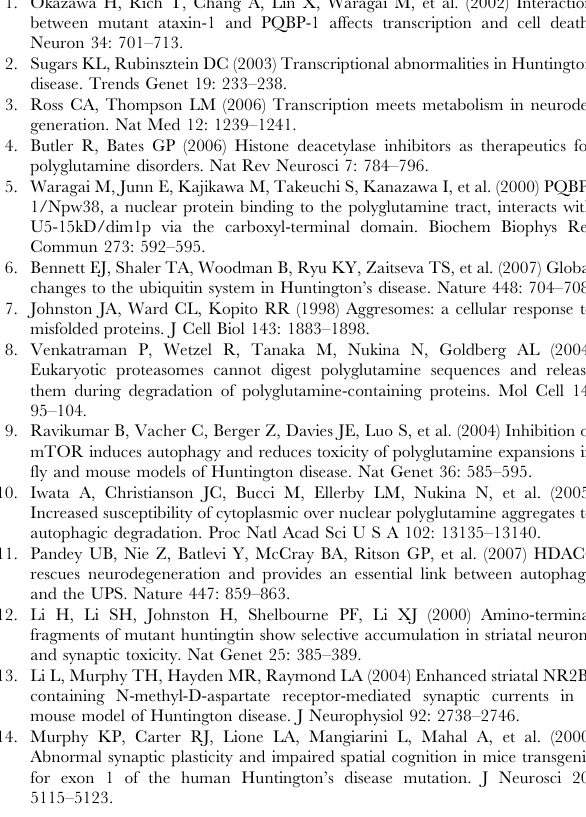
Figure S1 Different lifespans between Canton S and w 1118 genetic background flies. The lifespan was different among Canton S homozygous, w 1118 homozygous, and compound heterozygous background flies. Figure S2 The lifespan of the Canton S background flies was not affected by OK6 or Ku70 transgene. (A) Lifespan was not different between genetic controls and Ku70 overexpres- sion fly. OK6/ + (w/Y; OK6-Gal4/ + ; + / + ), Ku70/ + ; Htt 103Q/ + OK6-Gal4/UAS-mKu70; + / + ). All flies tested were male. (B) Eclosion rate was not different between genetic controls and Ku70 overexpression fly. The genotypes were, Canton-S (wild type),